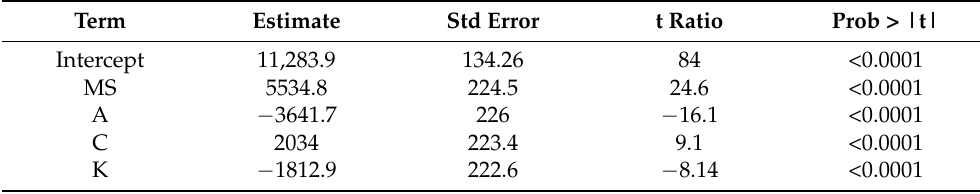
Table 1. Parameter estimates of linear model effects.